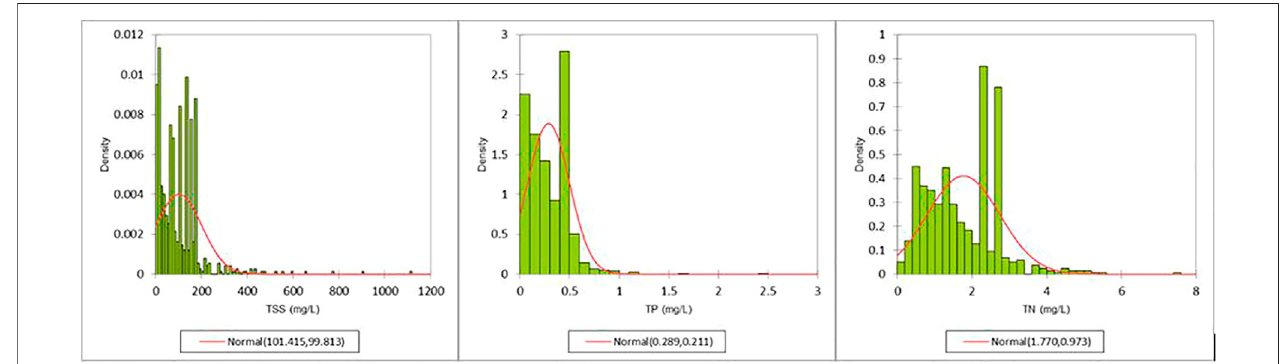
FIGURE 2 | Positively skewed distributions for TSS, TP and TN from residential